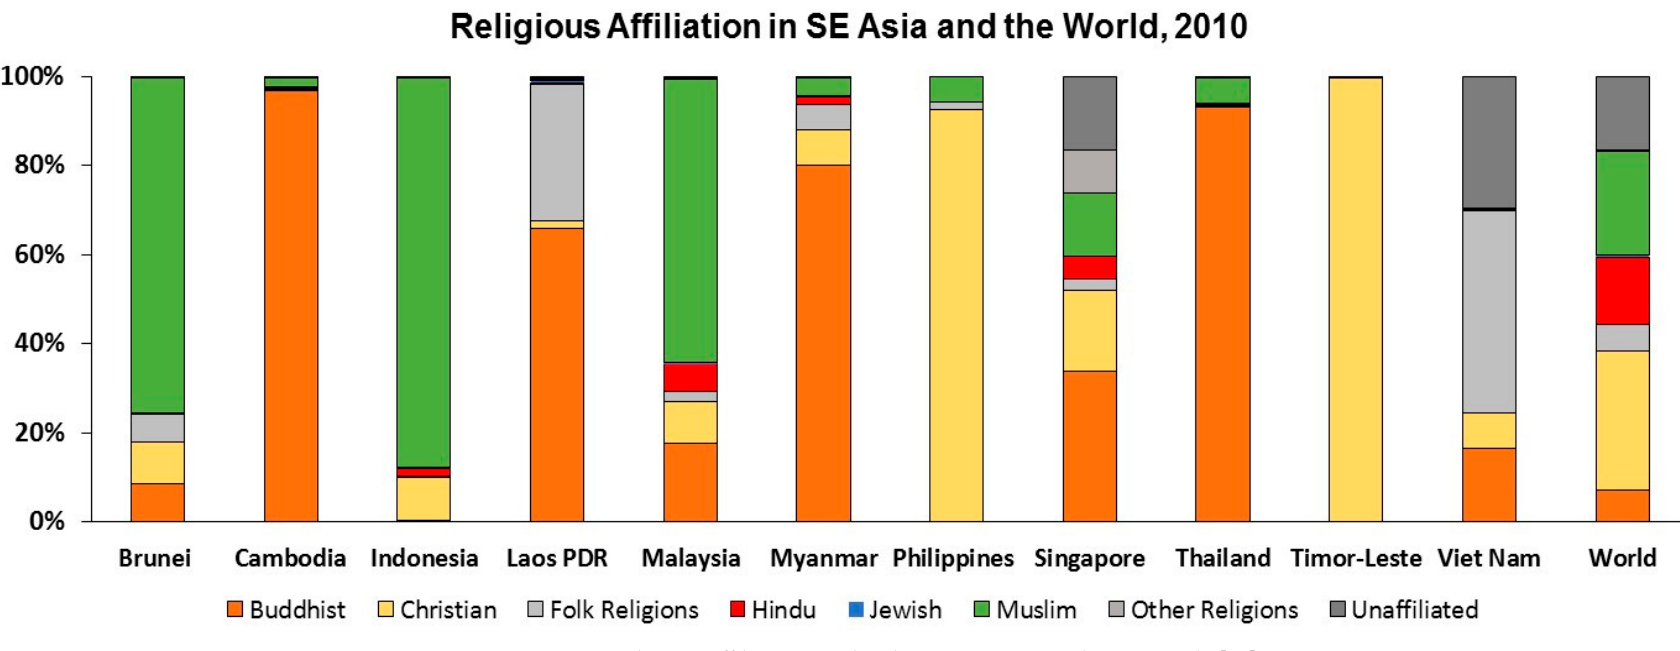
Figure 8. Primary religious affiliations in the eleven countries in the case study [17].